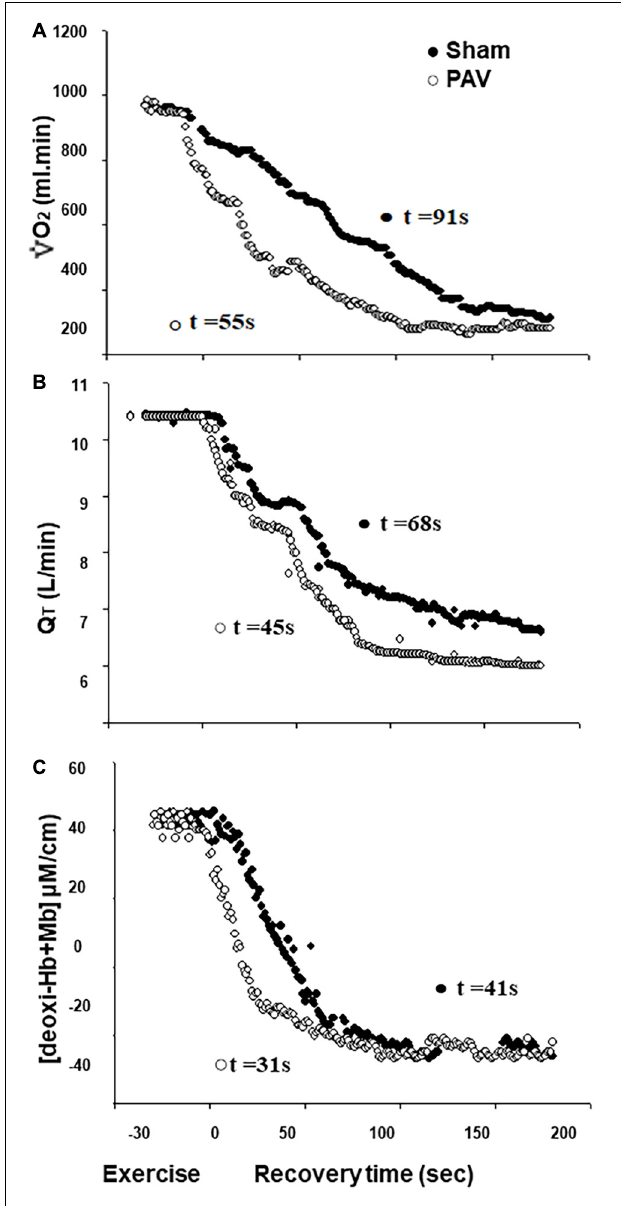
FIGURE 1 | Pulmonary O 2 uptake [˙VO 2 p , (A) ], cardiac output [Q T , (B) ], and deoxy-hemoglobin concentration [deoxy-Hb + Mb, (C) ] off-kinetics variables at high-intensity constant workload exercise test of a representative patient with HFrEF contrasting PAV